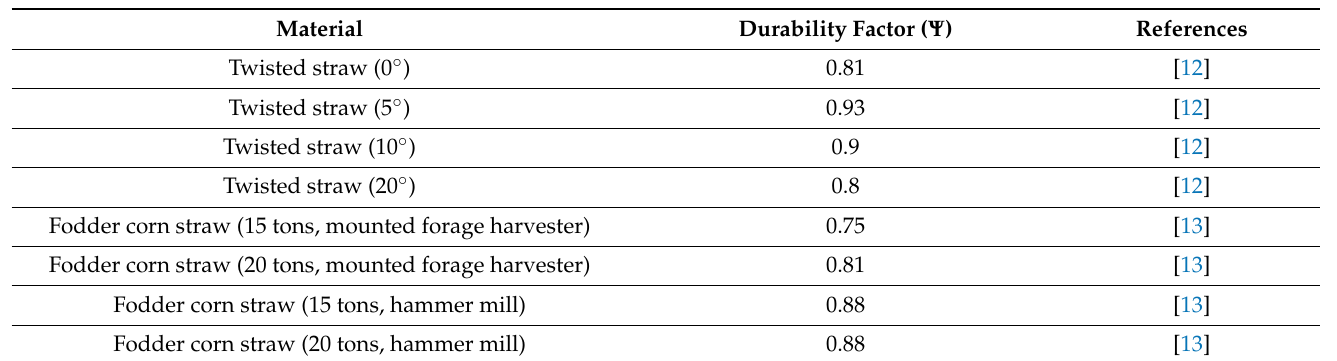
Table 1. The summary of the durability factor ( Ψ ) of briquettes made of various types of raw